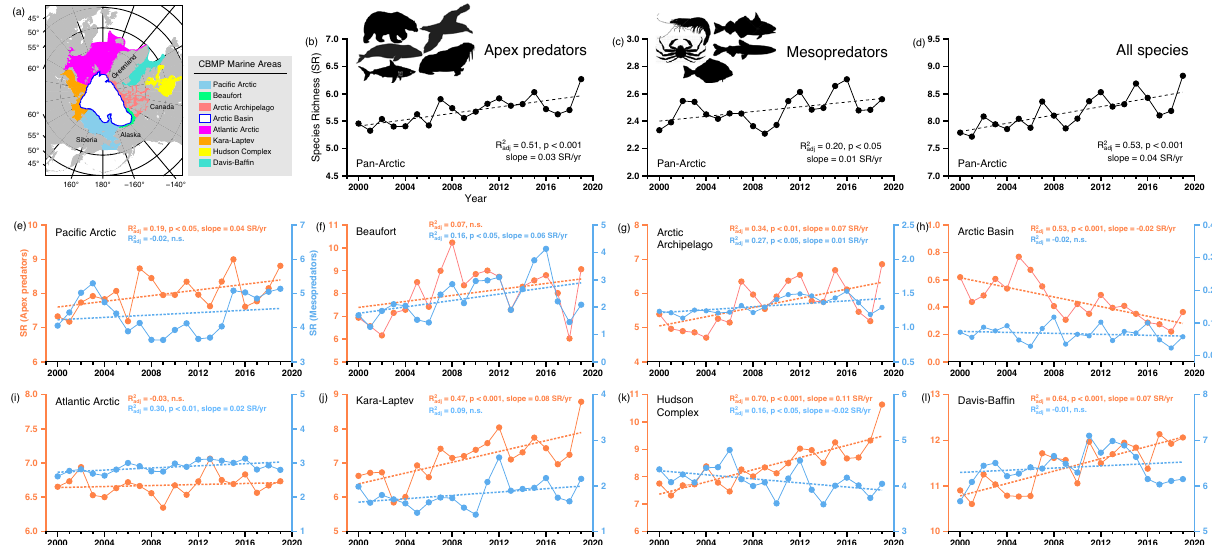
Figure 1. ( a ) Geographic map of the study area and annual time-series of predicted pan-Arctic species richness for ( b ) apex predators, ( c ) mesopredators, and ( d ) all species combined. Second and third row of panels show regional species richness by year with estimated linear trends over time for apex predators (orange) and mesopredators (blue) in the ( e ) Pacific Arctic, ( f ) Beaufort, ( g ) Arctic Archipelago, ( h ) Arctic Basin, ( i ) Atlantic Arctic, ( j ) Kara–Laptev, ( k ) Hudson complex, and ( l ) Davis-Baffin between 2000 and 2019. The map in ( a ) was created using GMT 6.3.0. (https:// docs. gener ic- mappi ng- tools. org/6. 3/ gmt. Temporal trends of species co‑occurrence. Potential associations from co-occurrences between two species were classified into positive, negative and random and showed a predominance of positive co-occurrences across all CBMP areas (Fig. 3a–h). This suggests that most species pairs occur together and are positively associated. The frequency of co-occurring species were highest in the Pacific and Atlantic Arctic, but no significant trends were observed on these inflow shelves during the last 20 years (Fig. 3a,e). In contrast, significant increases in positive species associations over time were observed in the Beaufort (Fig. 3b), Arctic Archipelago (Fig. 3c) and Kara–Laptev (Fig. 3f), with corresponding decline in Davis-Baffin (Fig. 3h). Negative co-occurrences, indicating non-co-occurrence and negative association between two species, were noted for the Atlantic Arctic (Fig. 3e) and Davis-Baffin (Fig. 3h), with a significant decrease in the latter. Random species co-occurrences implying independent distributions between species pairs, increased substantially in the Arctic Basin (Fig. 3d) and Davis- Baffin (Fig. 3h), but declined significantly in the Hudson Complex (Fig. 3g). Correlations between species rich- ness and co-occurrences (positive, negative and random) over the last 20 years were significant in all regions except the Pacific and Atlantic Arctic (Table S2). Marine community responses under contrasting sea ice conditions. Species richness and composi‑ tion. Differences in species richness of apex, mesopredators, and all species between low and high summer sea ice showed increases near the coasts and continental margins (Fig. 4a–c, left panels). However, decreases in apex predators in the Hudson Complex and Davis-Baffin (Fig. 4a, left panel) drove the overall species declines in these areas during low sea ice (Fig. 4c, left panel). Regions of high mesopredators were nearby shallow areas and southern waters of Pacific Arctic, Atlantic Arctic, and Davis-Baffin (Fig. 4b, left panel). Further, species compo- sition changes between high and low sea ice (Fig. 4a–c, middle panels) and measured using the beta-diversity index, showed different species composition for apex predators in the Arctic Basin and along continental slopes of the Kara-Laptev, Pacific Arctic, and Beaufort seas (Fig. 4a, middle panel). In contrast, highest changes in the species composition of mesopredators were observed west of the Pacific Arctic (Fig. 4b, middle panel). Over- all species composition between contrasting sea ice retained high dissimilarity along continental margins and slopes (Fig. 4c, middle panel), and were generally accounted for by the nestedness (i.e., species gain/loss without replacement) rather than the turnover (species replacement) component of beta-diversity (Fig. S5). In general, regional changes in biodiversity measures for apex, mesopredators and all species were driven by gains and losses across different areas of the Arctic due to habitat range size changes during high and low sea ice conditions (Fig. 4a–c, right panels). Species co‑occurrence. Frequencies of species co-occurrence (positive, negative, and random) between high and low summer sea ice differed across the Arctic marine areas (Fig. 5a–c). In particular, co-occurrences were largely dominated by co-occurring and positively associated species pairs (positive co-occurrence), with the highest frequency in the Pacific and Atlantic Arctic inflow shelves, albeit with opposite patterns between high and low sea ice (Fig. 5a). For non-co-occurring pairs (negative co-occurrence), however, inflow shelves patterns were consistent and showed more non-co-occurring pairs during low sea ice years (Fig. 5b). Davis-Baffin Bay